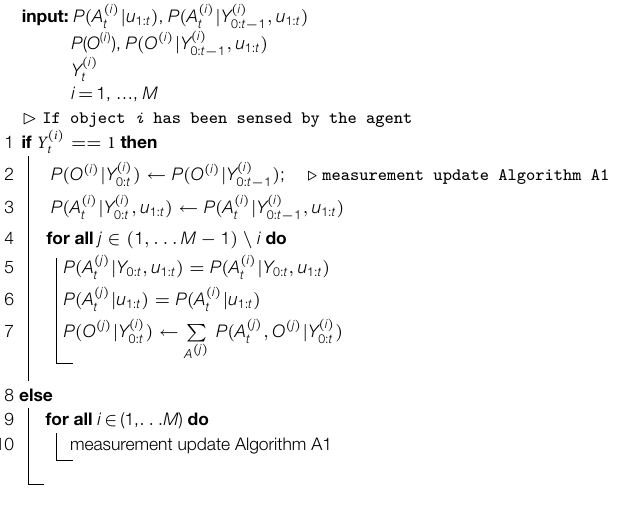
ALGORITHM A2 | Scalable-MLMF: Measurement